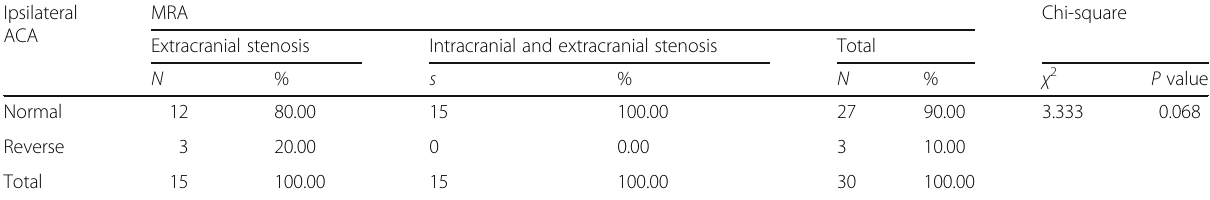
Table 1 Difference in ACA flow in both groups Ipsilateral MRA Chi-square ACA Extracranial